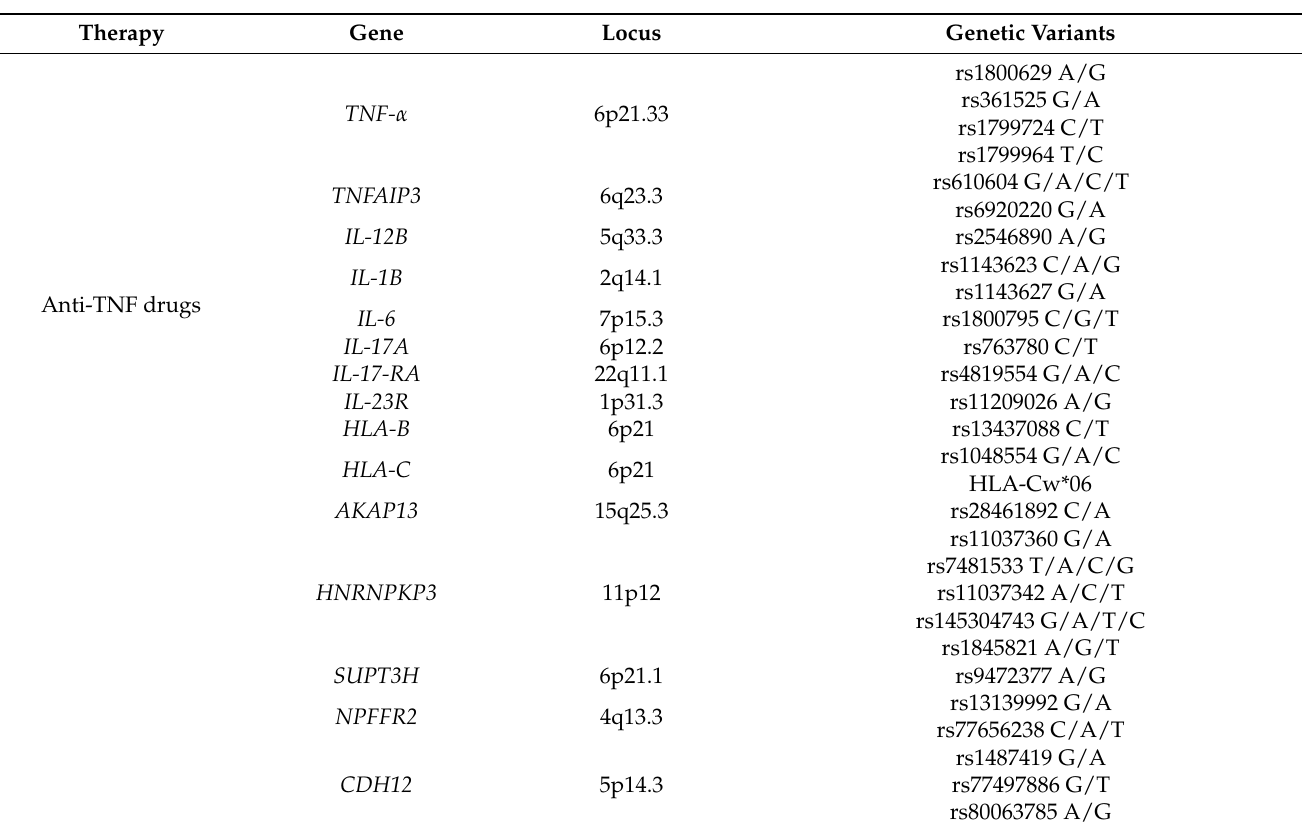
Table 1. Genes and genetic variants potentially involved in the response to anti-TNF